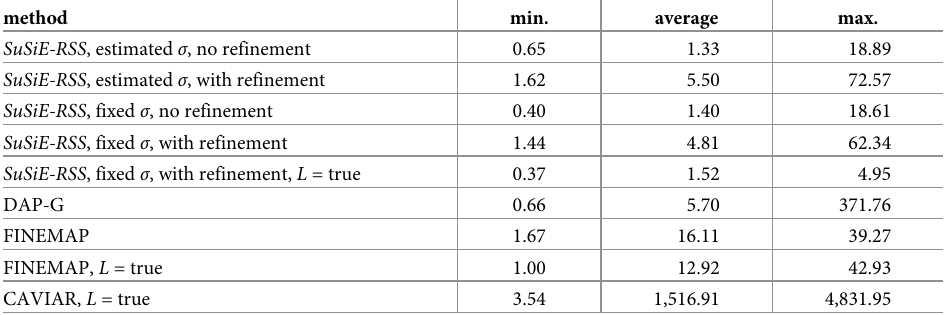
Table 2. Runtimes on simulated data sets with in-sample LD matrix. Average runtimes are taken over 600 simula- tions. All runtimes are in seconds. All runtimes include the time taken to read the data and write the results to files. method